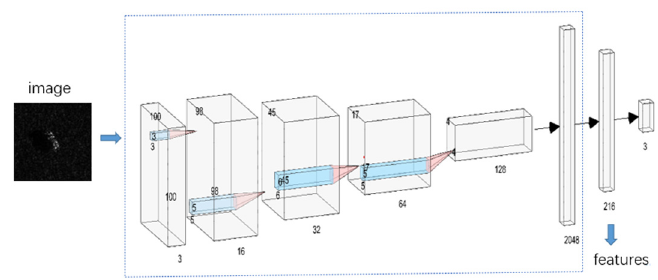
Figure 4. Feature extraction.